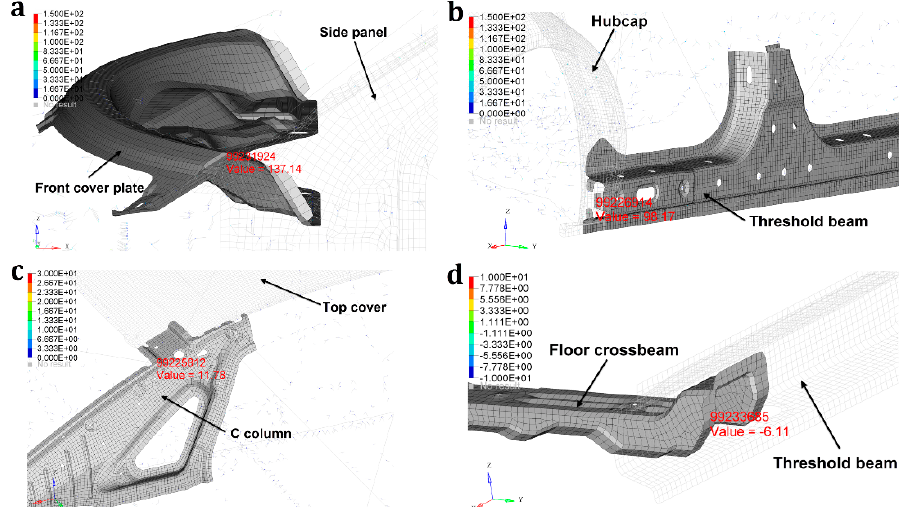
Figure 11. The element number and its stress value of the solder joints with maximum shear or axial stress. ( a ) Connector with maximum shear stress for the front cover plate; ( b ) connector with maximum shear stress for the threshold beam; ( c ) connector with maximum axial stress for the C column; ( d ) connector with maximum axial stress for the floor crossbeam. Table 8. Specific loadingmode and stiffness measurement results.